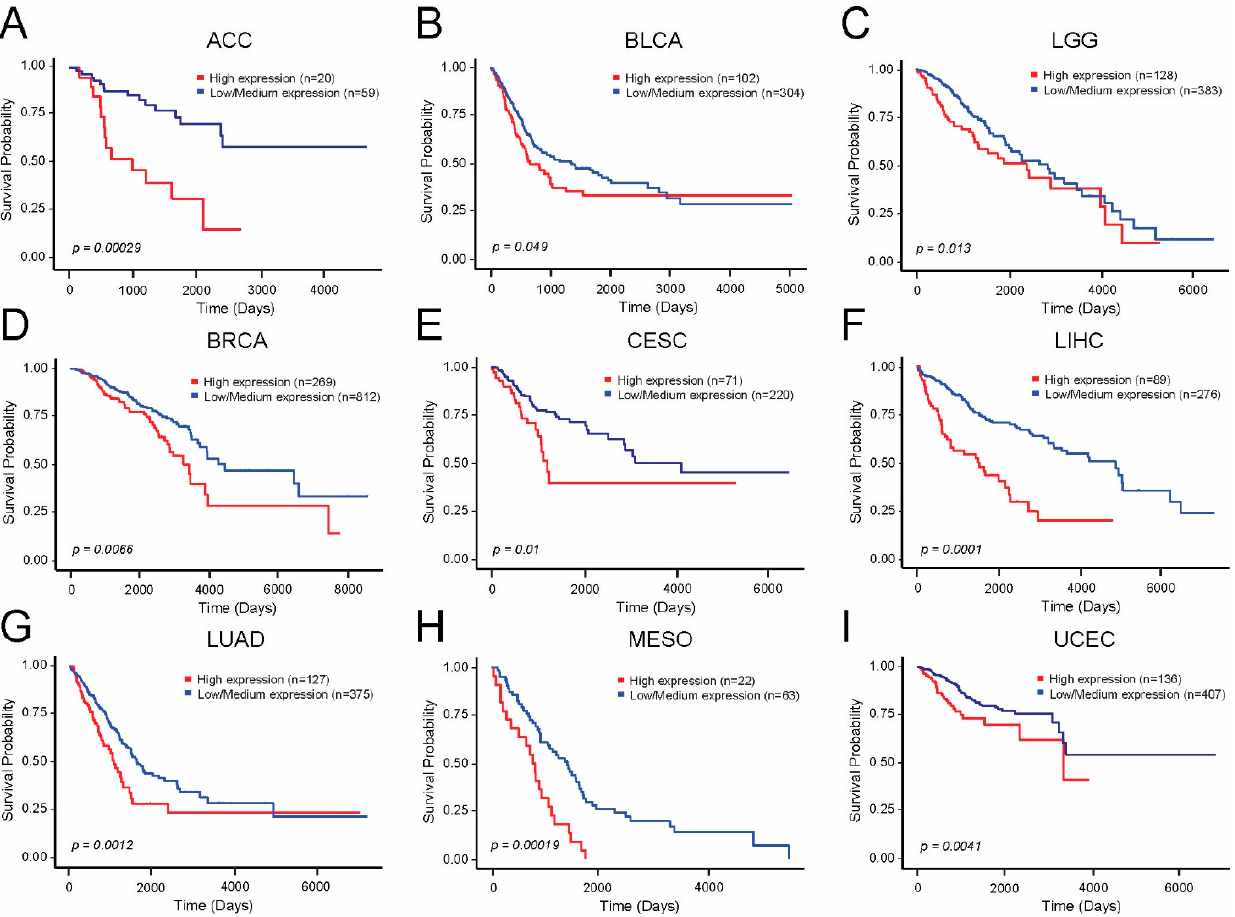
Figure 4. PSMD1 expression correlates with worse OS in multiple human malignancies. TCGA survival data from UALCAN demonstrates that higher levels of PSMD1 mRNA expression correlated with worse outcomes as demonstrated in the Kaplan-Meier curves for ( A ) ACC, adrenocortical carcinoma; ( B ) BLCA, bladder urothelial carcinoma; ( C ) LGG, Brain lower grade glioma; ( D ) BRCA, breast invasive carcinoma; ( E ) CESC, cervical squamous cell carcinoma and endocervical adenocarcinoma; ( F ) LIHC, liver hepatocellular carcinoma; ( G ) LUAD, lung adeno carcinoma; ( H ) MESO, mesothelioma; ( I ) UCEI, uterine corpus endometrial carcinoma.